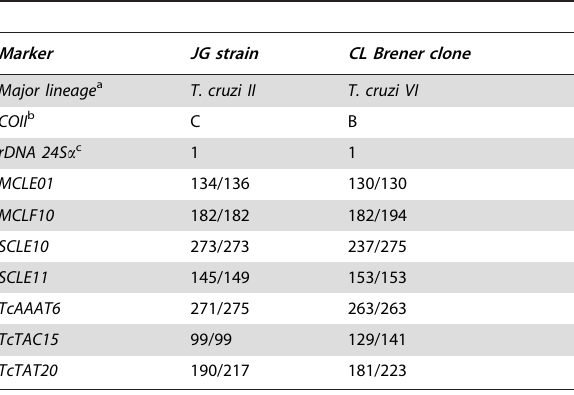
Table 1. Genetic characterization of nuclear and mitochondrial markers of the JG and CL Brener T. cruzi